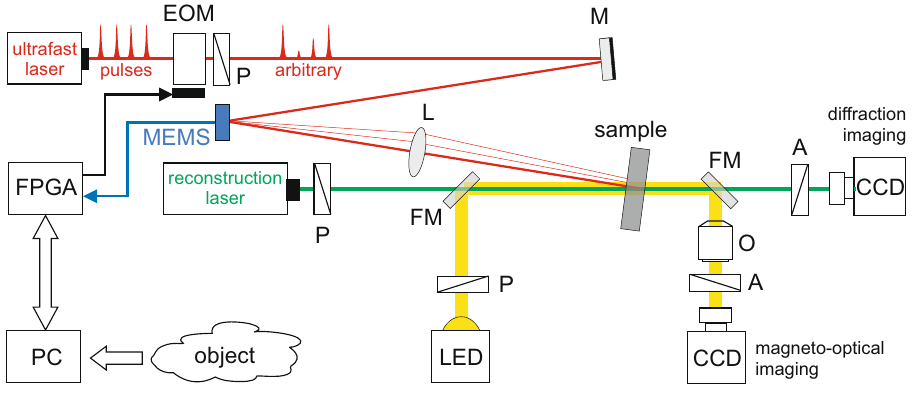
Fig.4|Schemeoftheexperimentalsetup. OutlineofCGHwritingandacquisition of diffraction and magneto-optical images using Faraday effect in a transmission geometry. L, convex lenses with a 100mm focal length, FM fl ip mirror, P polarizer,